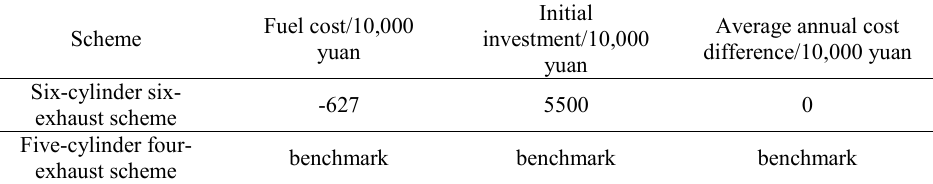
Table 6. Comparison of the annual cost of a single unit in the two